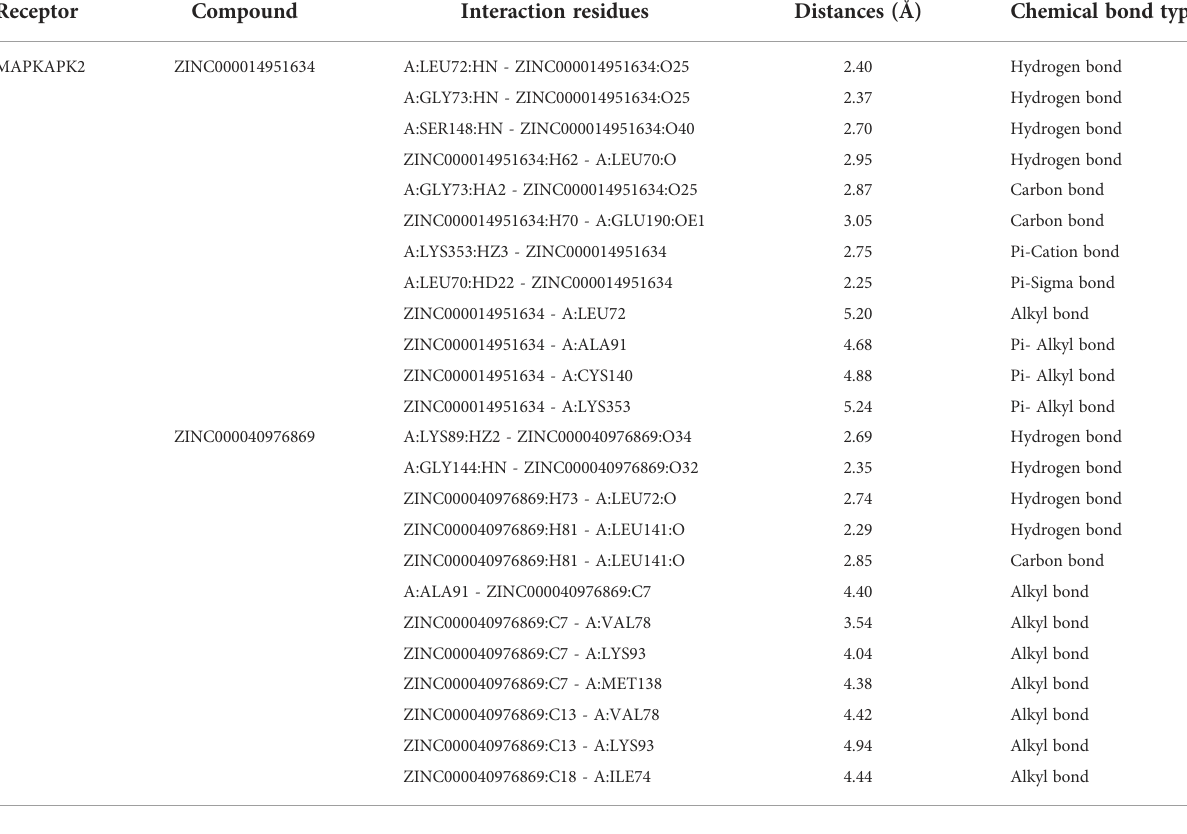
TABLE 5 Chemical bond interaction parameters of ZINC000014951634 and ZINC000040976869 ligands with MAPKAPK2 residues. Receptor